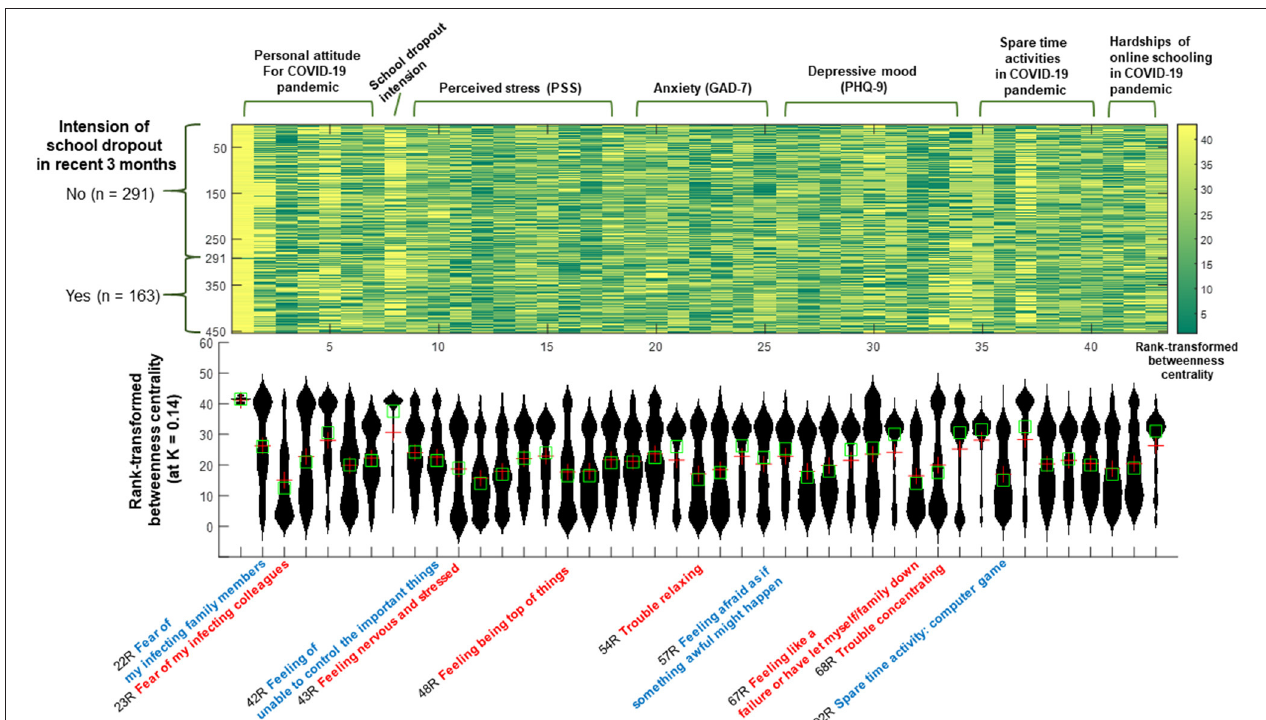
FIGURE 2 | Rank-transformed betweenness centrality calculated from the intra-individual covariance networks of changes in lifestyle, personal attitudes, perceived stress, anxiety, and depressive mood among Korean medical students during the COVID-19 pandemic. In the x-axis of the violin plot (lower), the following six most influential items (hubs; top 12% for the rank-transformed betweenness centrality in ≥ 25% of participants ( n = 454) at a network sparsity level of K = 0.14) are written in red: (1) personal attitude, fear of infecting my colleagues (R23); (2) perceived stress, feeling nervous and stressed (R43); (3) perceived stress: feeling “being on top of things” (R48); (4) anxiety, trouble relaxing (R54); (5) depressive mood, feelings of failure or that I have let myself/family members down (R67); and (6) depressive mood, trouble concentrating on things (R68). Items that showed significant relationships with recent intentions to drop out of school, perceived stress, or depressive mood are written in